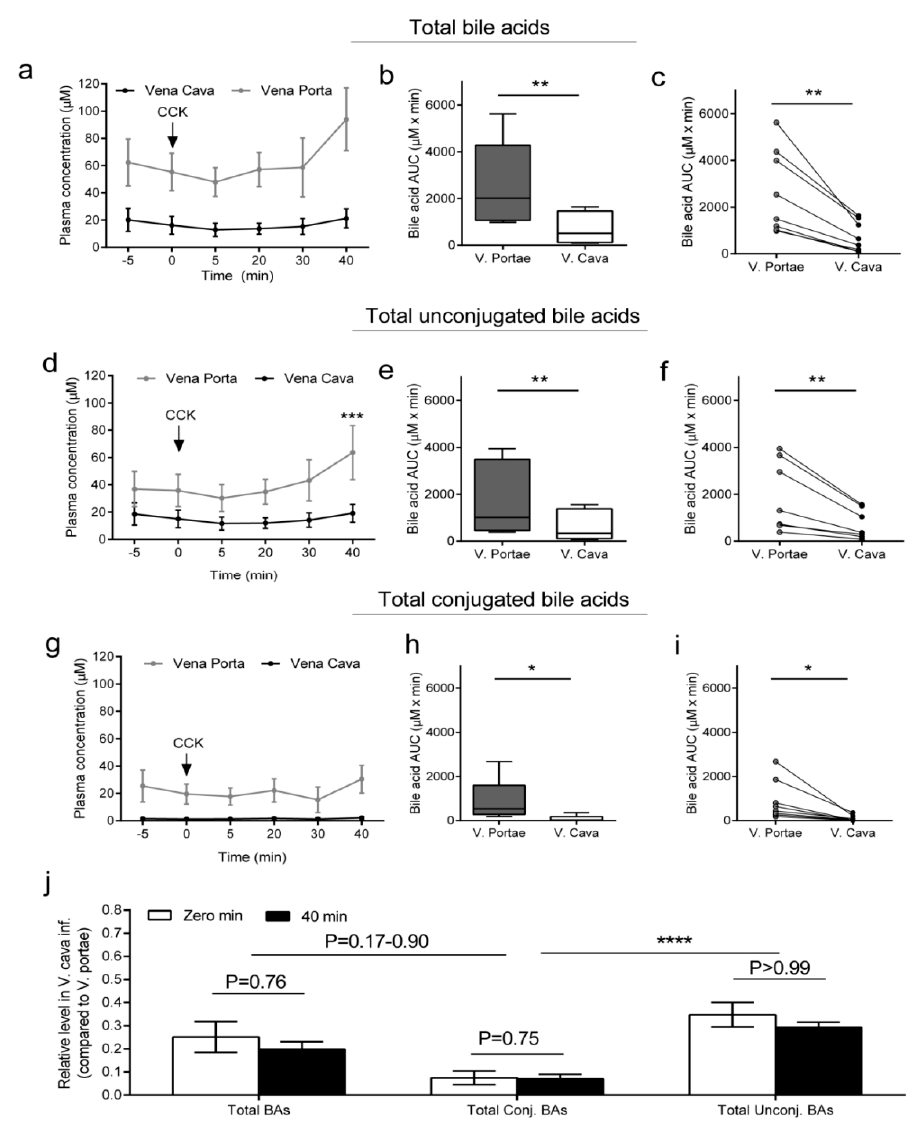
Figure 1. Total, total unconjugated, and total conjugated bile acid. Concentrations are shown at individual time points (means ± SEM, µ M) and by AUC values from − 5 to 40 min ( µ M × min) as well as by relative levels (means ± SEM) in vena cava (V. cava) compared to levels in vena portae (V. portae). AUC values are presented as box and whisker plots as well as connected individual AUC-values ( µ M × min). ( a – c ): Total bile acids (sum of total unconjugated and total unconjugated), ( d – f ): Total unconjugated bile acids, ( g – i ): Total conjugated bile acids, ( j ): Relative levels of total, total unconjugated, and total conjugated bile acid levels in V. cava compared to V. portae before injection of CCK (sulfated CCK-8) (zero point, white boxes) and 40 min after injection (black boxes). Zero point was calculated by taking the average of − 5 and 0 min concentrations. Grey: Vena portae, black: vena cava. * p < 0.05, ** p < 0.01, **** p < 0.0001. Statistical significance was tested by paired student t -test. n =